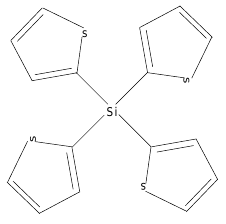
Figure 5. The graph of organosilicon dendrimer G [ 1